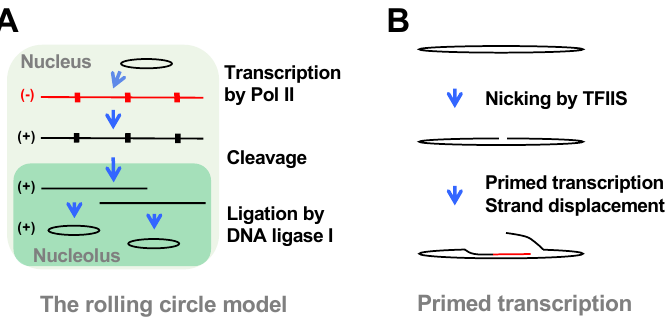
Figure 3. PSTVd rolling circle model ( A ) and a hypothetical primed transcription scheme ( B ). The nodes in the ( − )- and ( + )-concatemers in ( A ) depict the cleavage sites for generating unit-length copies. Black lines depict sense orientation of PSTVd, while red lines depict antisense orientation of PSTVd. Using the partially purified Pol II from wheat germ, we performed the in vitro transcription